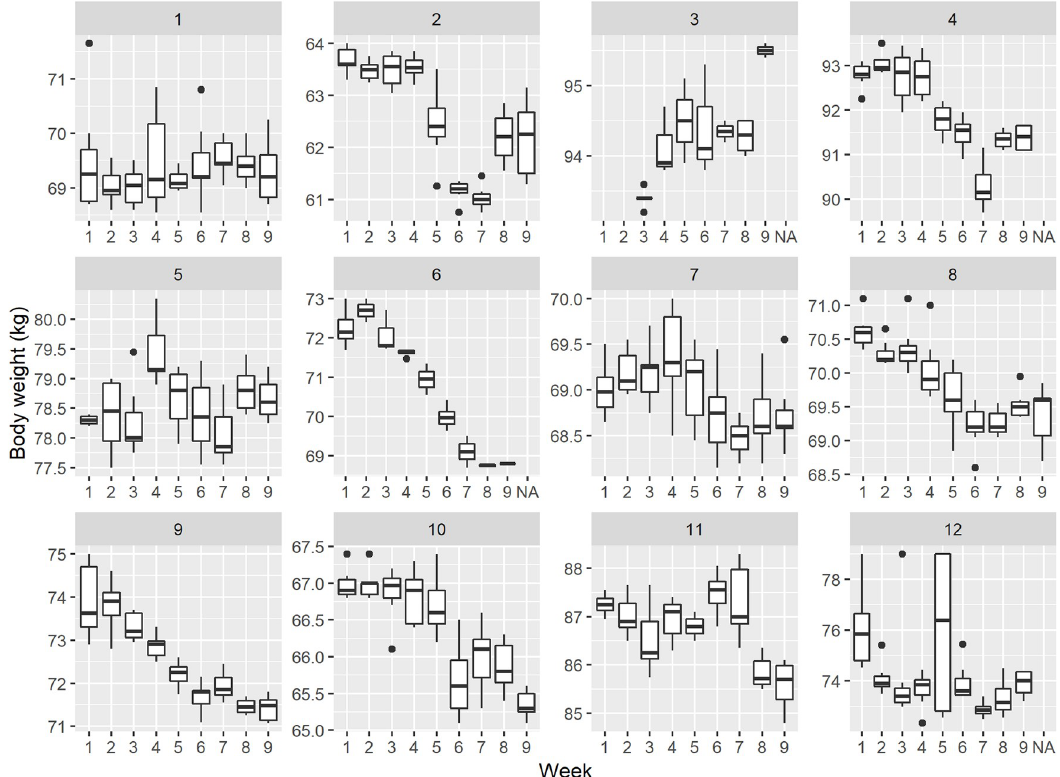
Fig 5. The distributions of observed body weight measurements per week and per